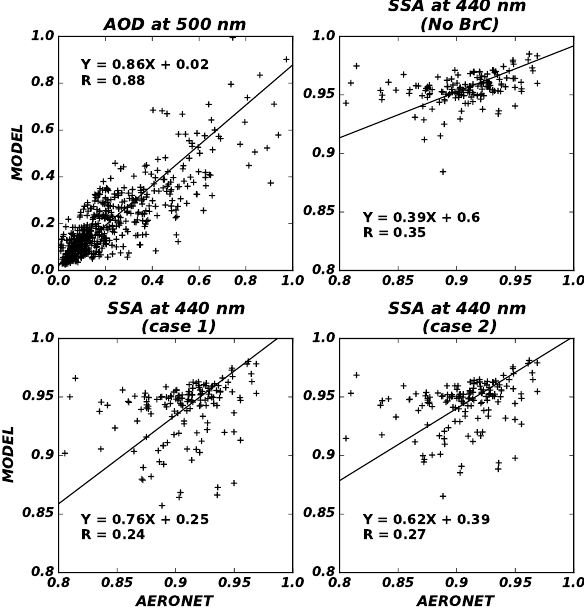
Figure 5. Scatter plots of simulated versus observed AOD at 500nm (upper left), SSA at 440nm without BrC (upper right), SSA at 440nm with BrC of case 1 (lower left), and SSA at 440nm with BrC of case 2 (lower right) for 2007. Reduced major axis regres- sion is shown along with the regression equation and R . Each point indicates monthly averaged AOD or SSA when the number of ob- servation is greater than 10